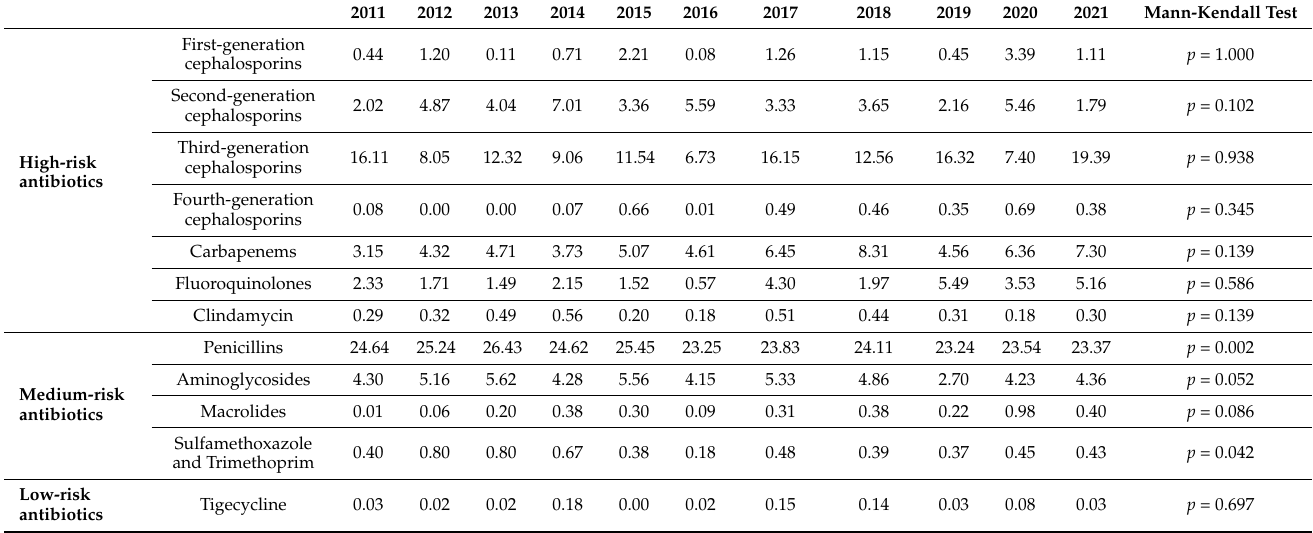
Table 4. The consumption of antibiotics according to the risk for Clostridioides difficile infection in defined daily doses (DDD) per 100 bed-days (BD) from 2011 to 2021.